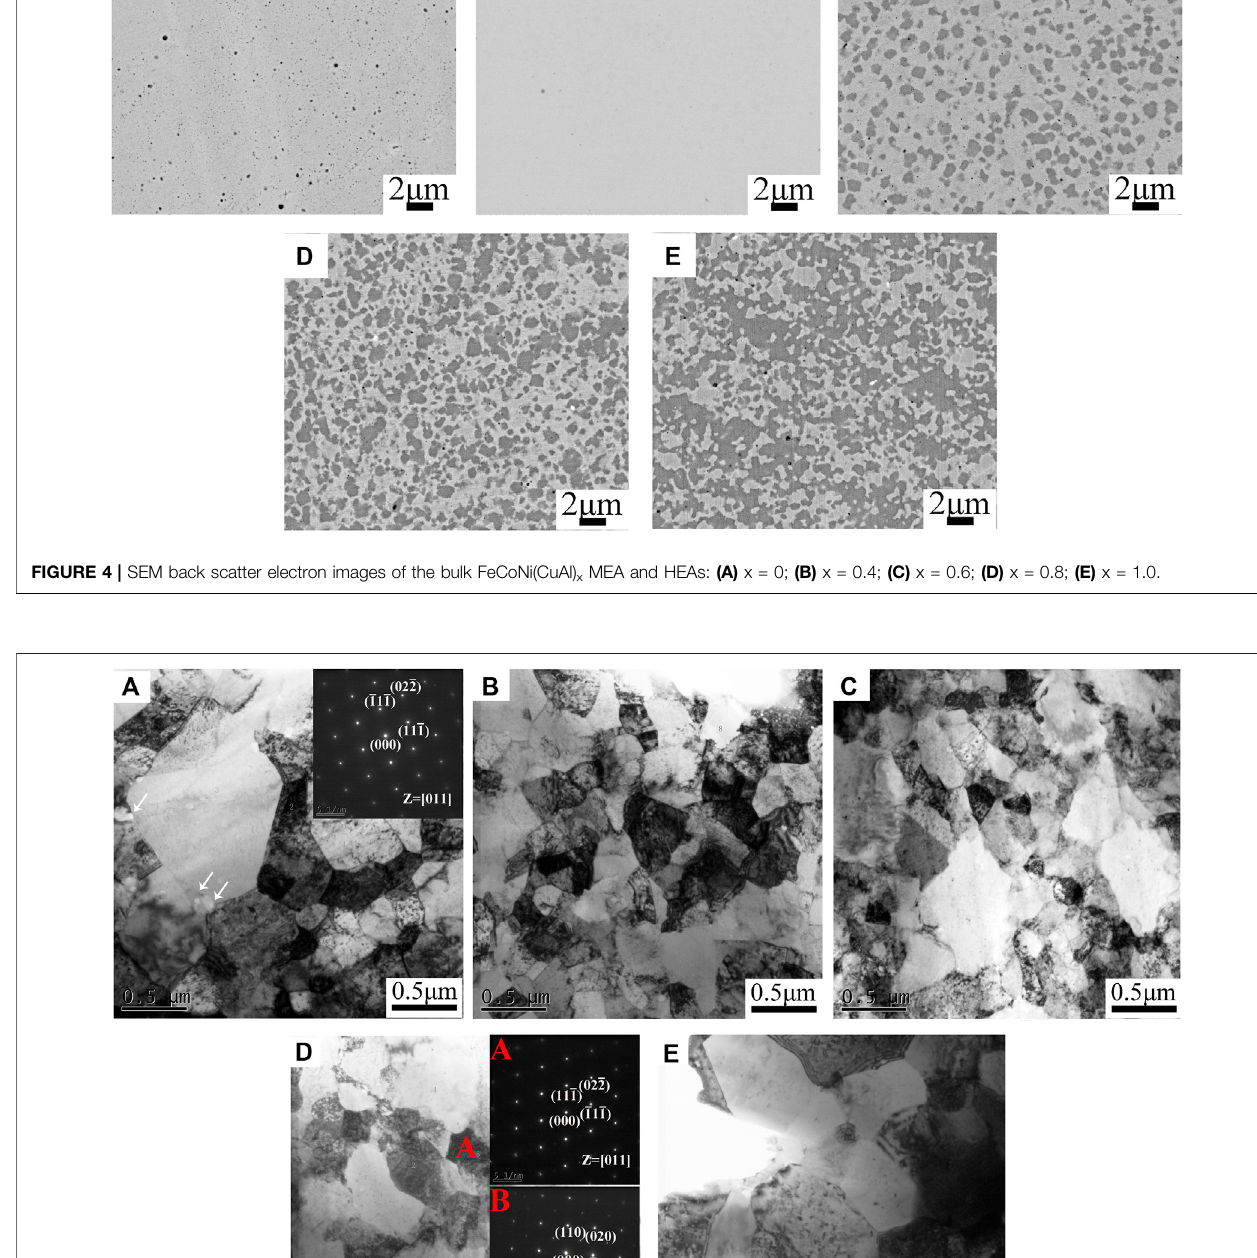
Frontiers in Materials |